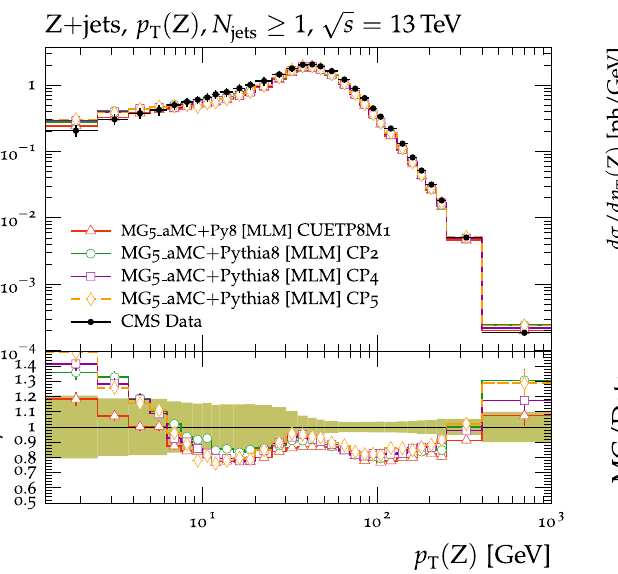
Fig. 24 Comparisonwiththemeasurement[71]ofthe p T (Z)predicted by mg5 _a mc + pythia 8 with k T –MLM merging (left) and FxFx merg- ing (right) for the different tunes. Tunes CP1 and CP3 are not shown in the plot but they present a similar behaviour as tunes CP2 and CP4, respectively. The ratios of simulations to the data (MC/Data) are also